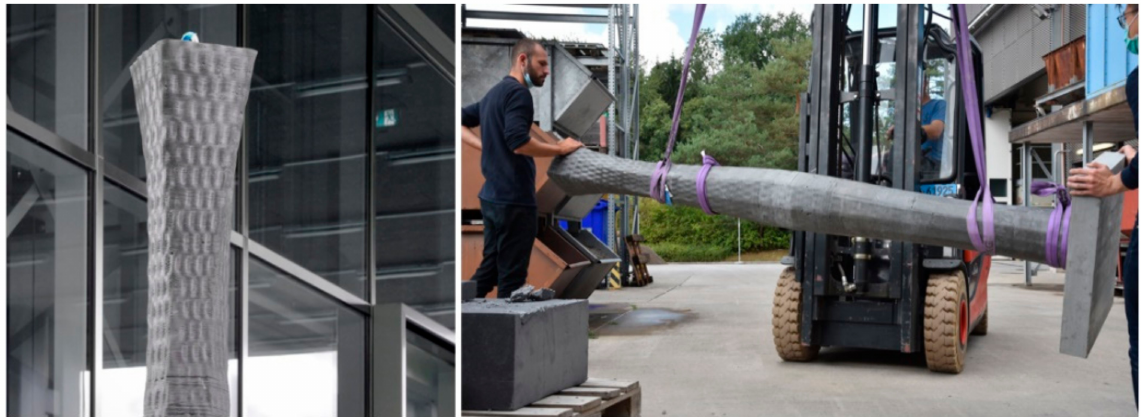
Figure 13. ( Left ) zoom of cast eggshell columns after demolding; ( right ) transport of